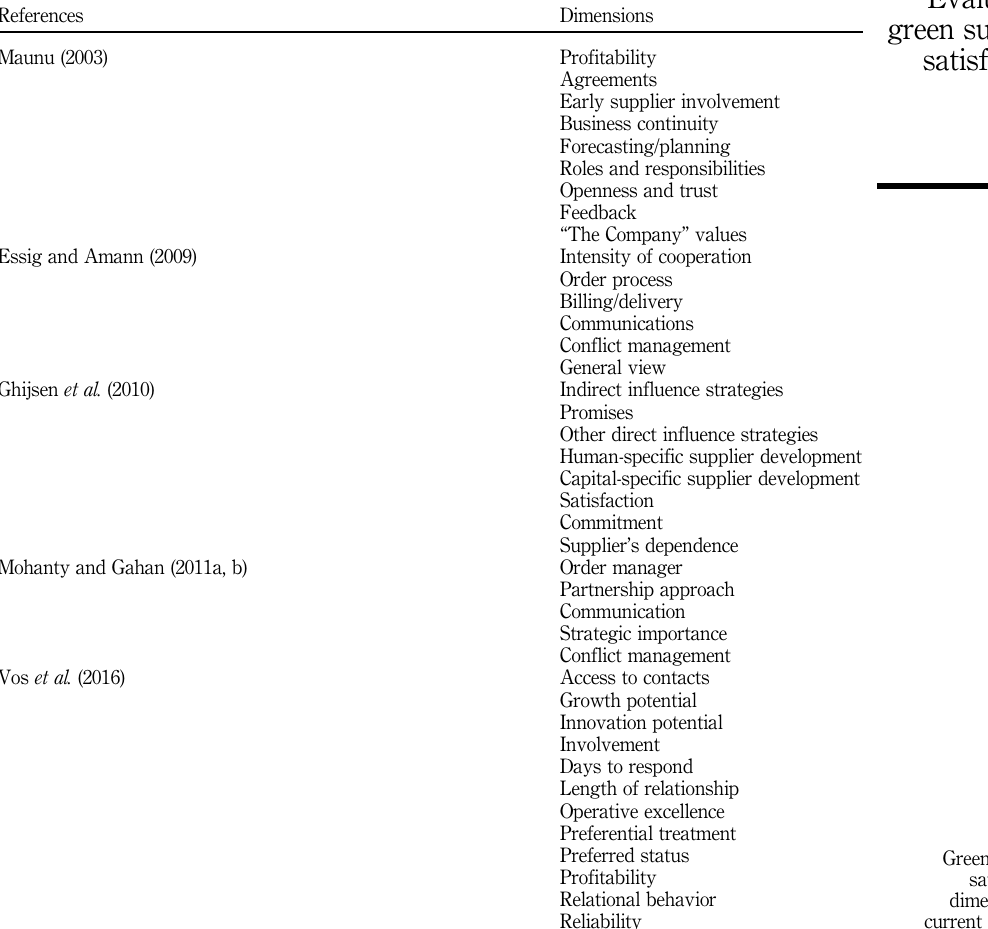
Table I. Green supplier satisfaction dimensions